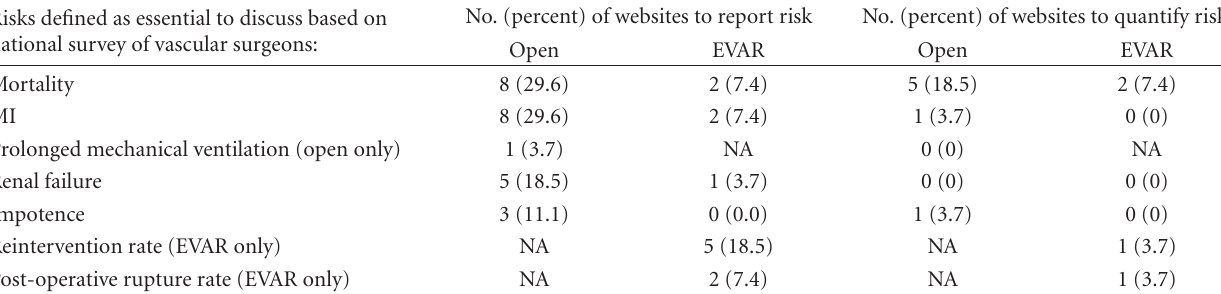
Table 3: Risk and benefits of treatment